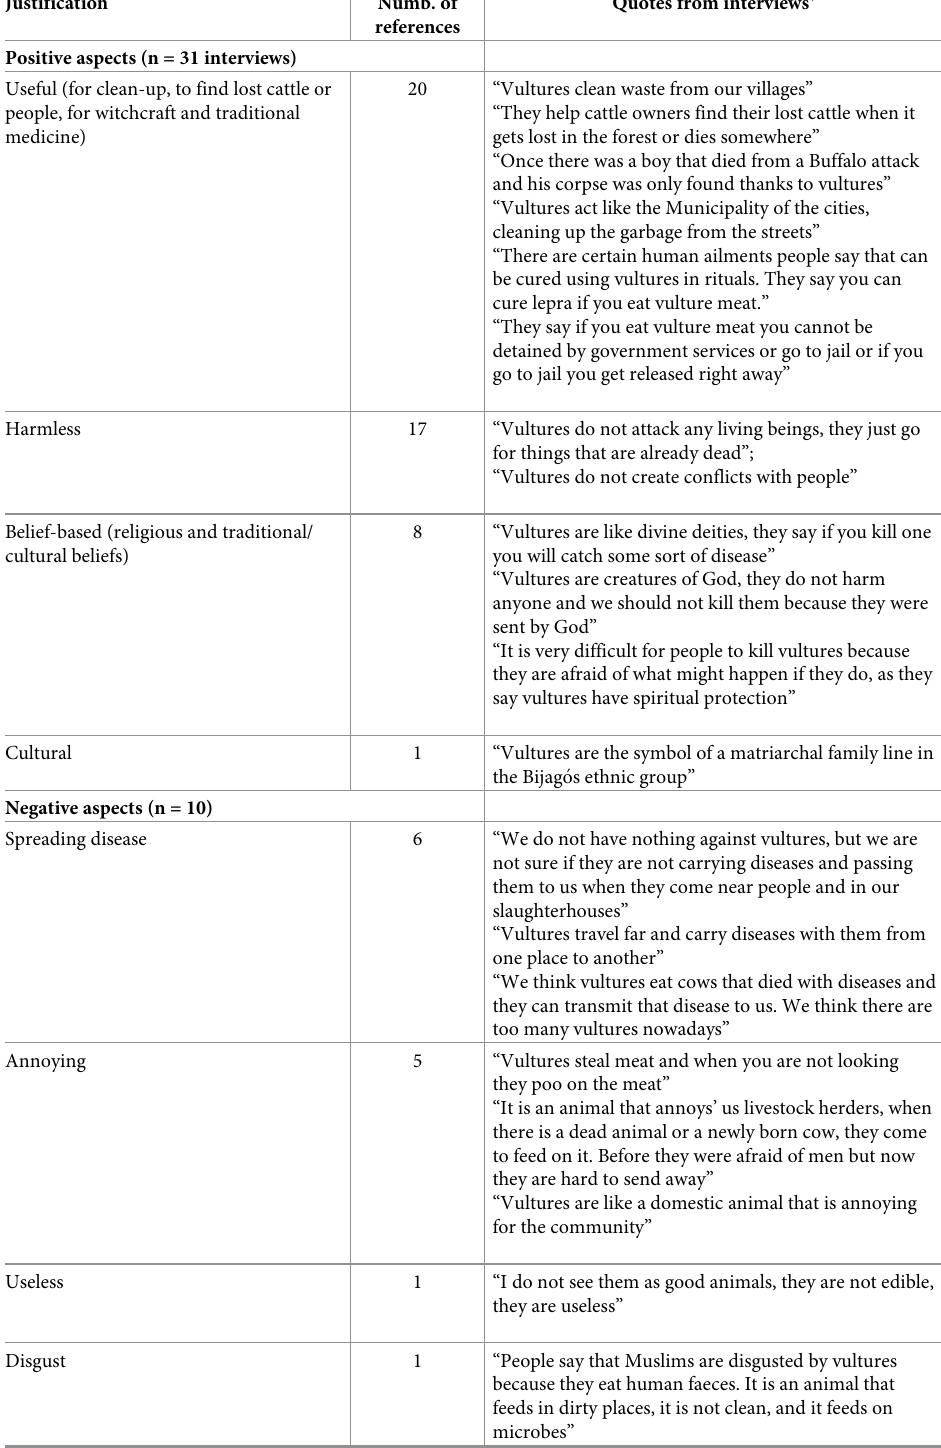
Table 4. Perceived positive or negative aspects of vultures according to stakeholders. Perceived positive or negative aspects of vultures according to stakeholders in Guinea-Bissau, with categories expressed as percentages and with example quotes. Each interview could refer more than one reason (46 and 13 references to positive and negative rea- sons,